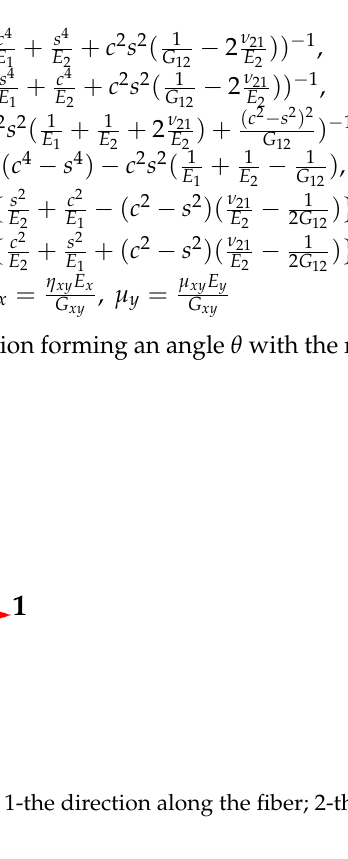
Table 2. Modulus of elasticity of the tire elements, MPa.